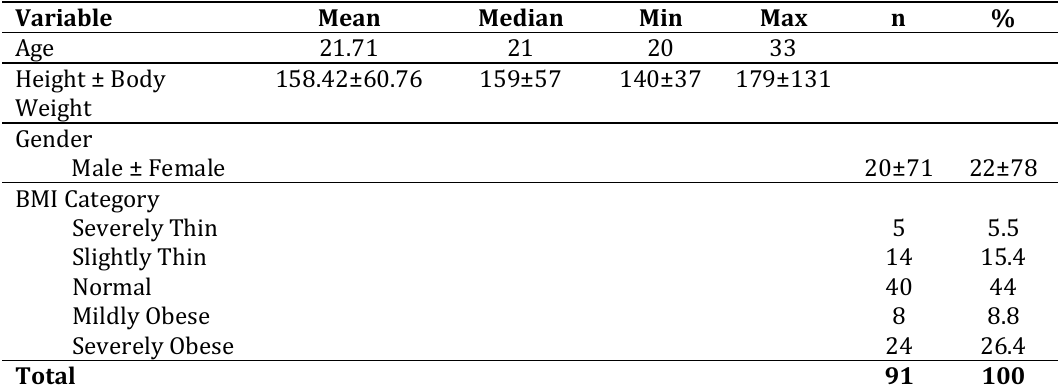
Participant’s Demography Characteristics Based on Age, Gender, Height, Weight, and BMI